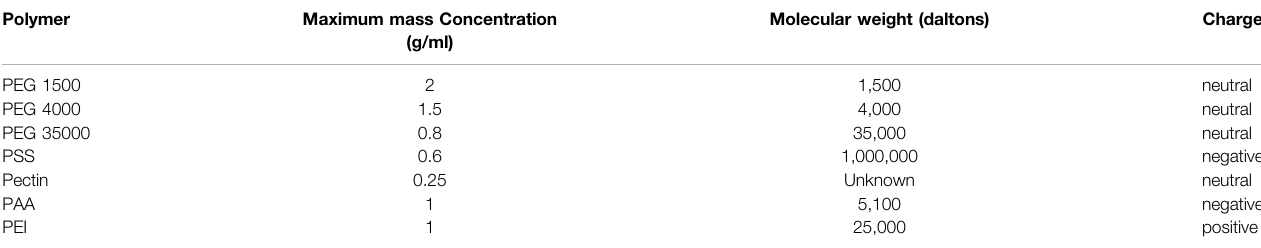
TABLE 1 | Polymers prepared at maximum mass